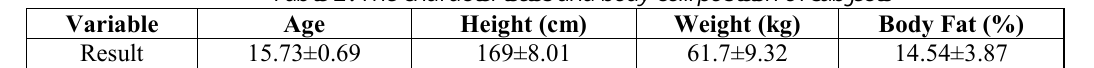
Table 1. The characteristics and body composition of subjects